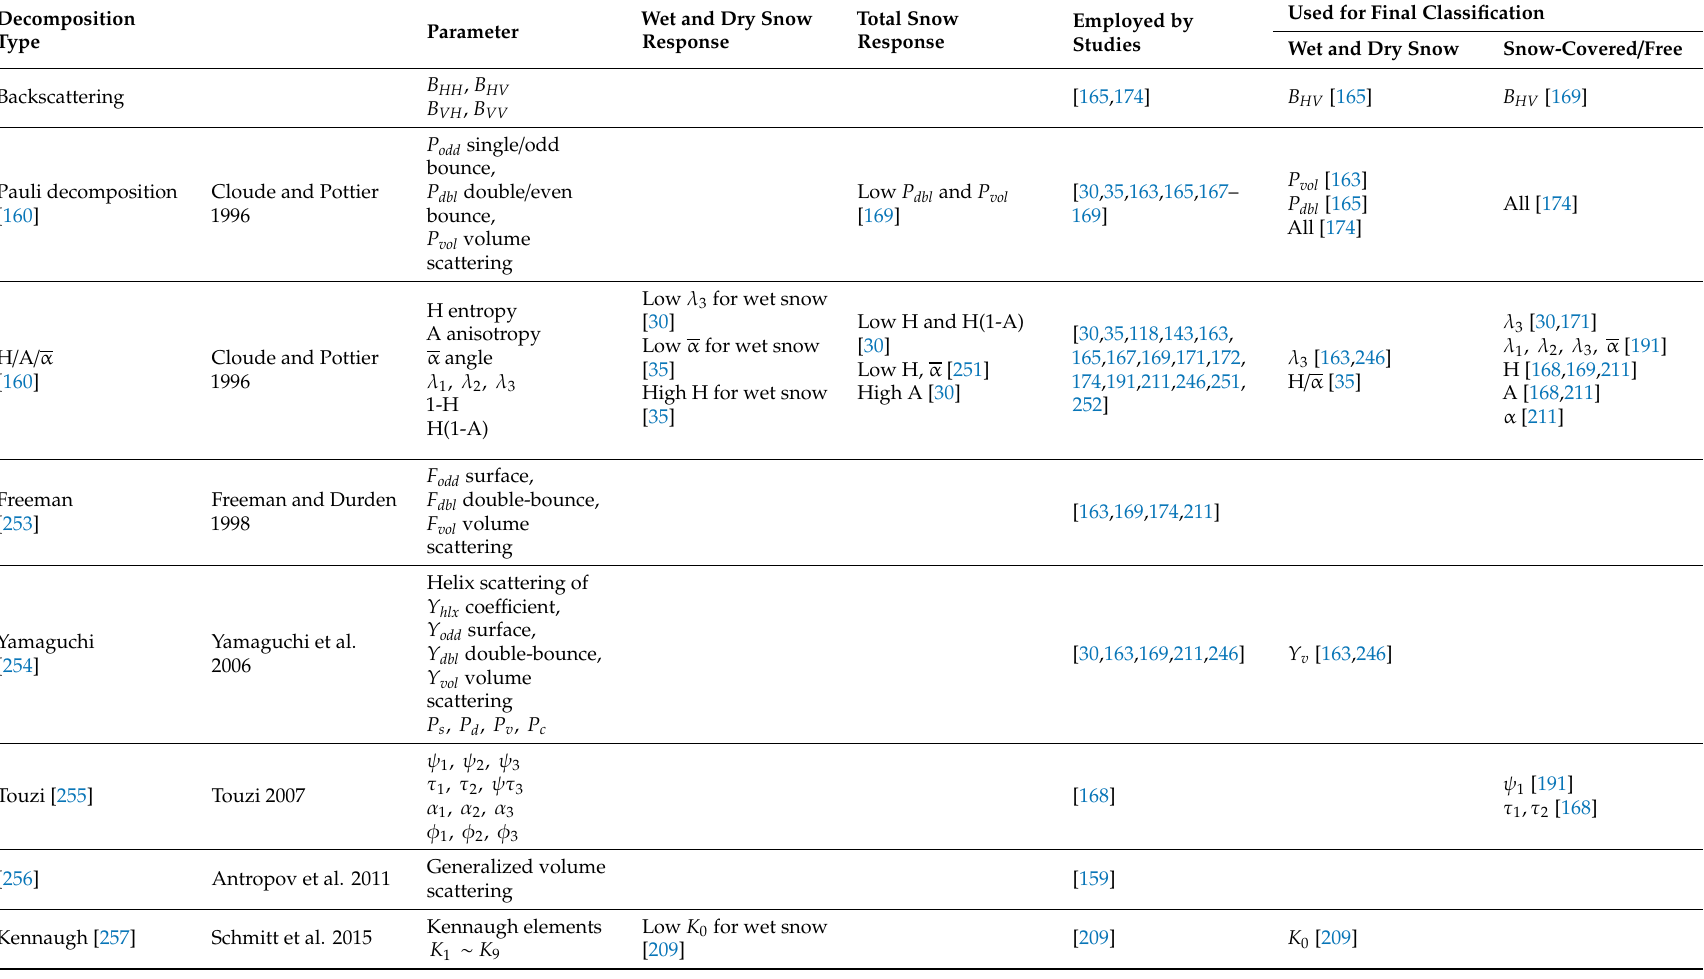
Table A3. The PolSAR decomposition techniques and parameters employed in the included